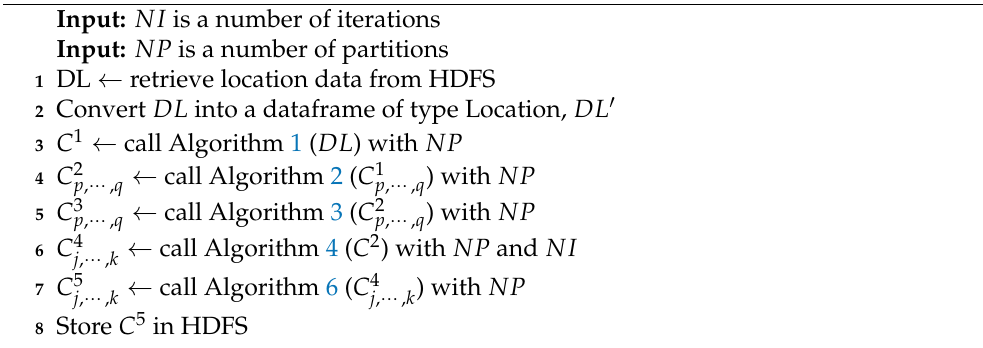
Algorithm 7: Algorithm for a privacy-preserving trajectory publication